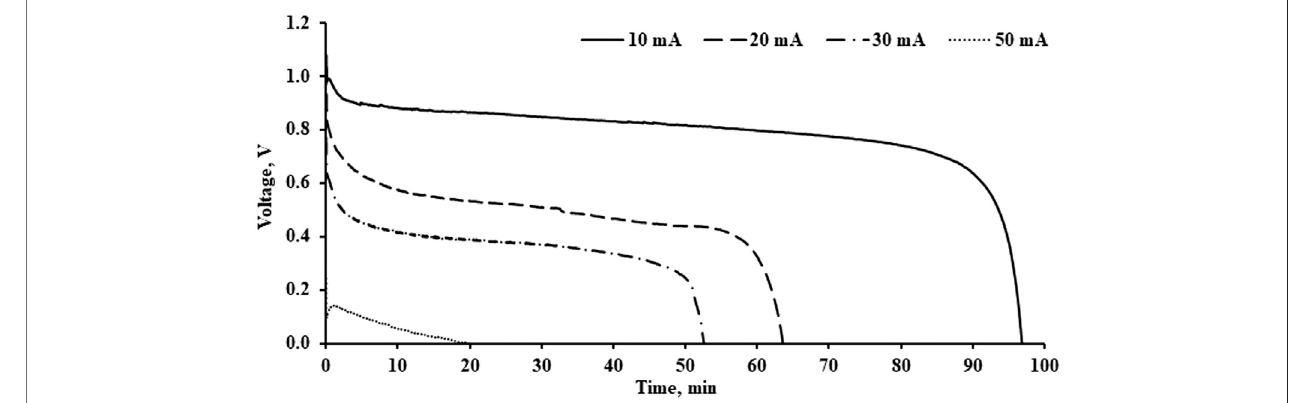
FIGURE 4 | Discharge performance of Al-air battery with 1M KOH electrolyte.